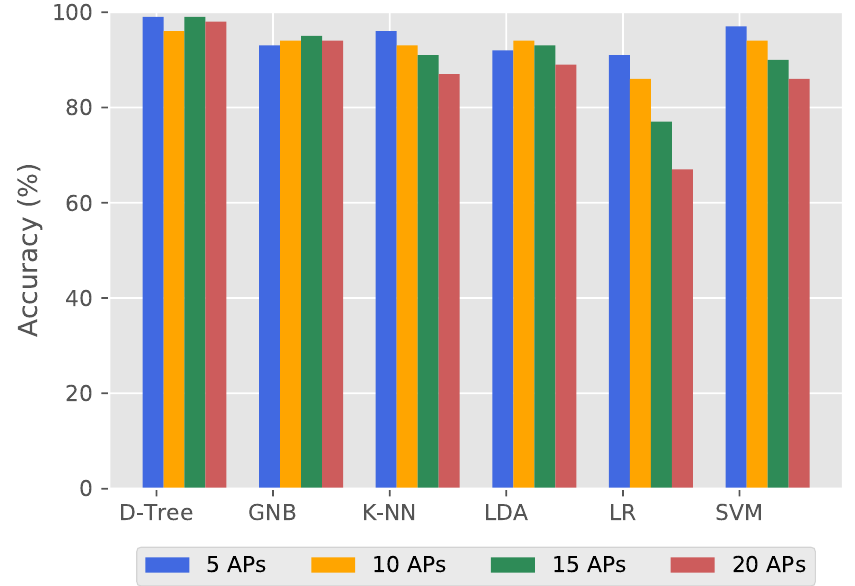
Figure 7. Average accuracy with a different number of APs using the RSSGM model.